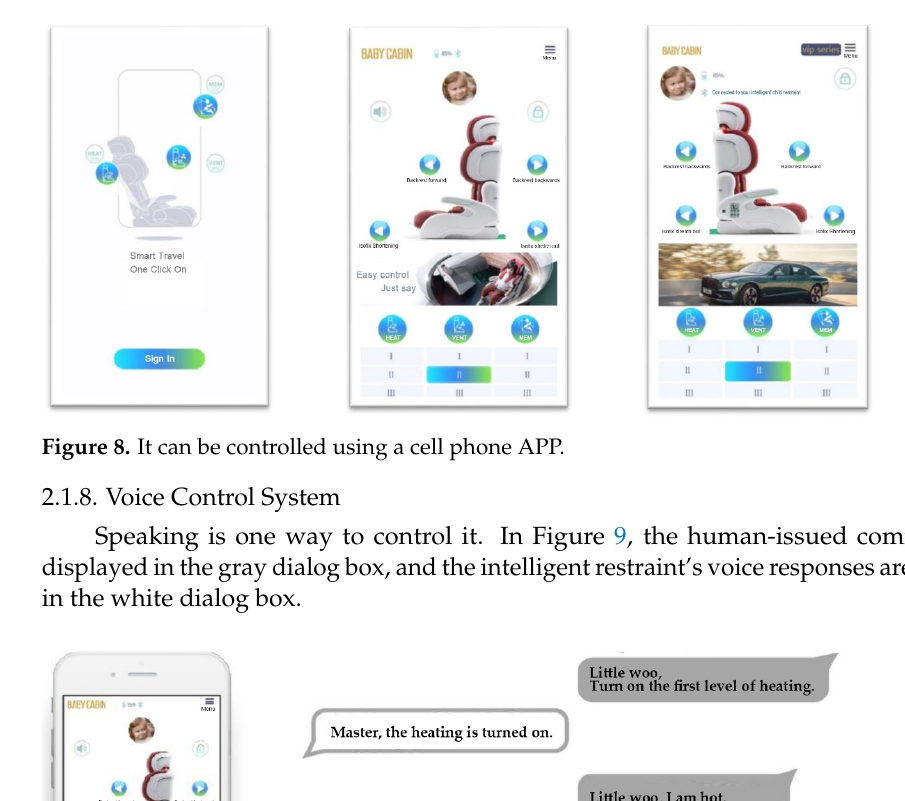
Figure 7. Foldable.